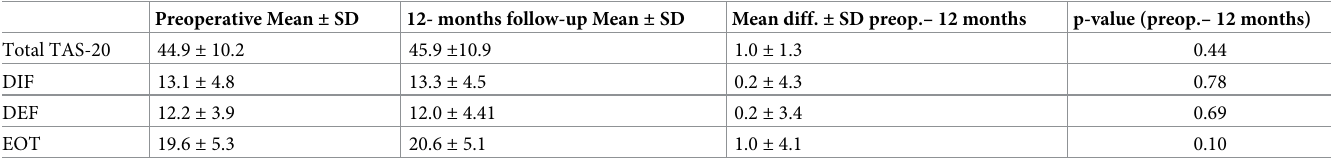
Table 5. Toronto Alexithymia Scale (TAS-20) total score and subscores. Preoperative Mean ±